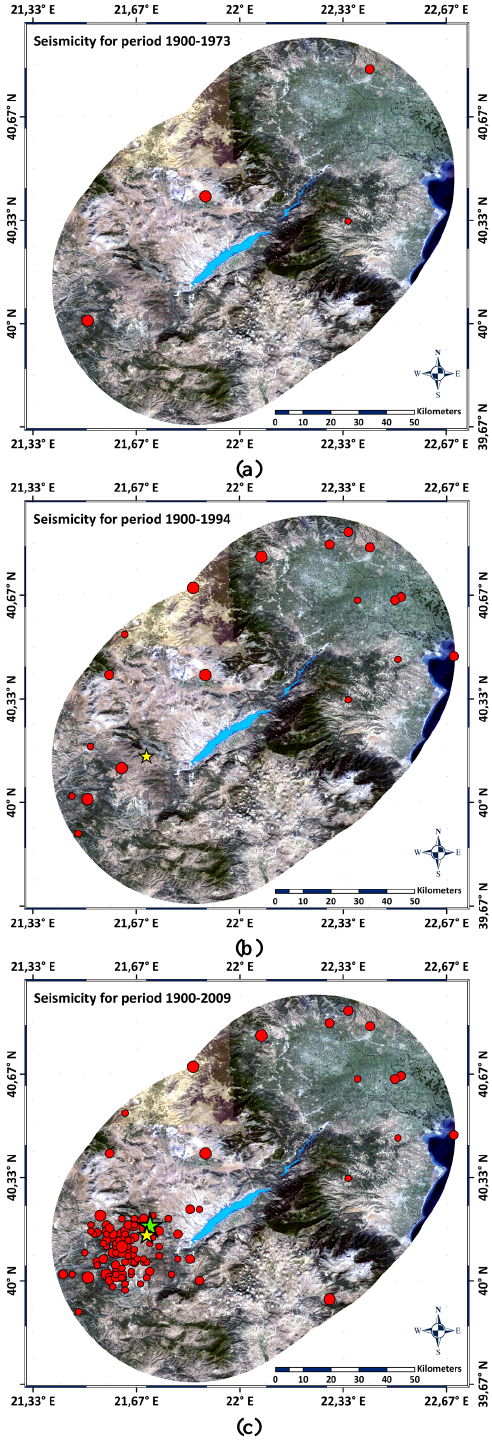
Fig. 7. (a) Spatial distribution of seismicity ( M s ≥ 4) for the period: 1900–1973. (b) Spatial distribution of seismicity ( M s ≥ 4) for the period: 1900–1994. (c) Spatial distribution of seismicity ( M s ≥ 4) for the period: 1900–2009.